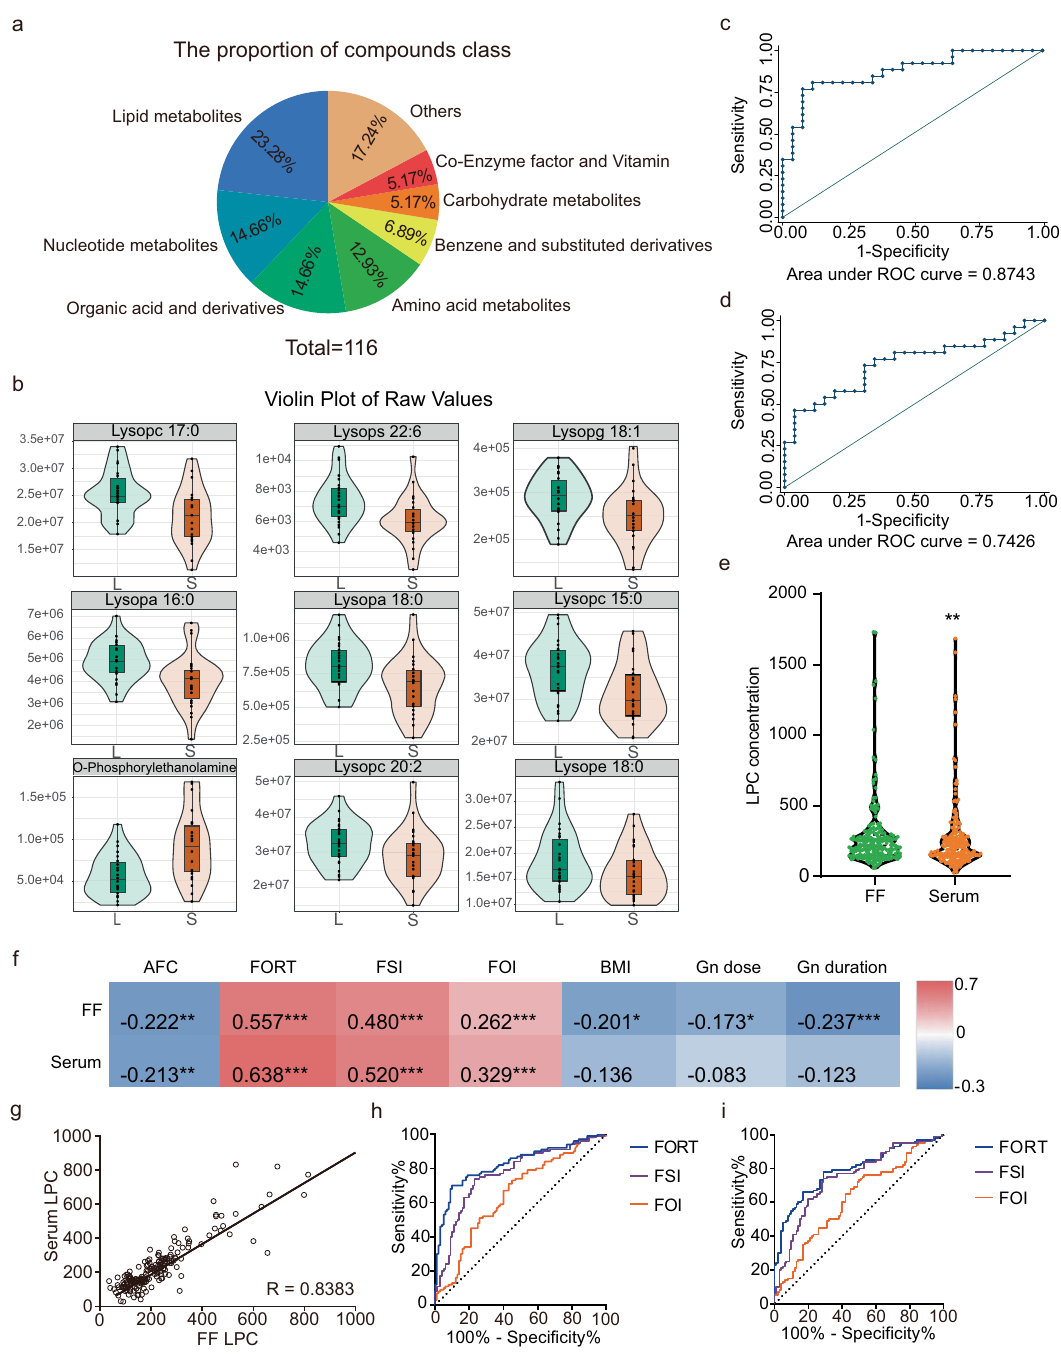
Fig. 6 The lipid phospholipids in relation to follicular development in blood serum and follicular fl uid. a 116 differential metabolites divided into 8 classes, based on substance categories. b A violin diagram of nine lipid phospholipids showing data distribution and density. c ROC curves of the nine major lipid phospholipids found in differently sized follicles. d ROC curves of LPC in the follicular fl uid of differently sized follicles. e Markedly different lysophosphatidylcholine (LPC) concentrations (pg/ml) in the follicular fl uid and blood serum. f Relationship between LPC and epidemiological information, including BMI, AFC, ovarian stimulation parameters (Gn dose and duration), and ovarian sensitivity parameters (FORT, FSI, and FOI). g A strong linear relationship between follicular fl uid LPC levels and blood serum LPC levels. h ROC curves for predicting ovarian sensitivity parameters (FORT, FSI, and FOI) using LPC levels in blood serum. i ROC curves for predicting ovarian sensitivity parameters (FORT, FSI, and FOI) using LPC levels in follicular fl